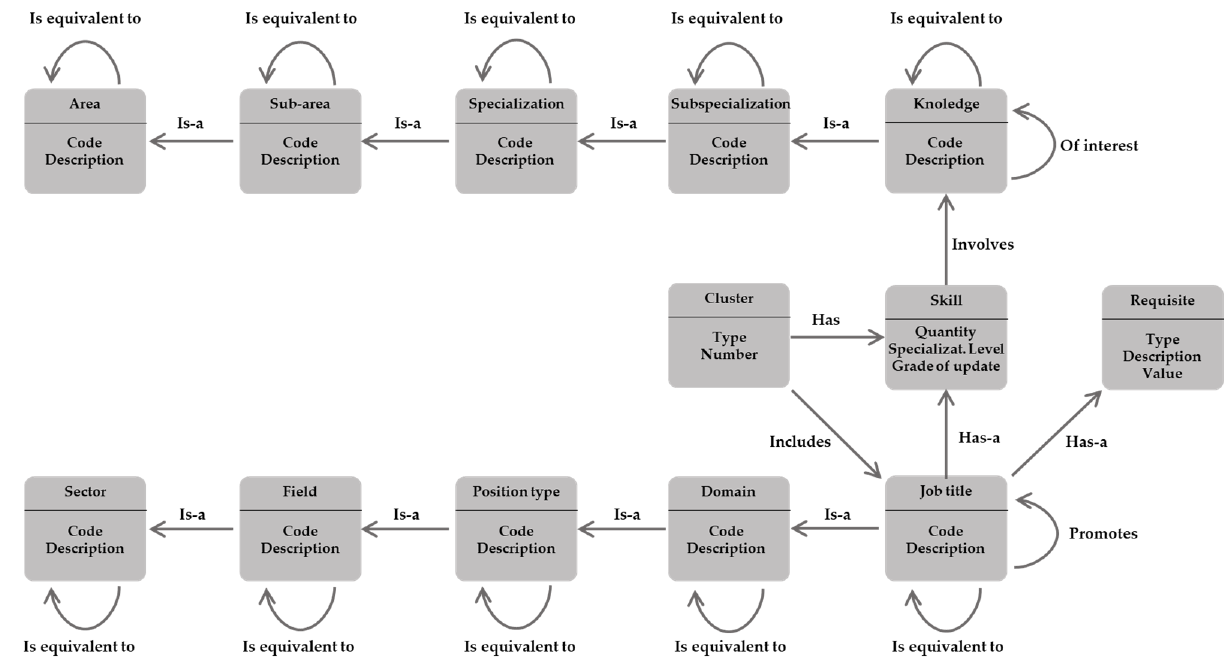
Figure 2. Ontology used in the RS.